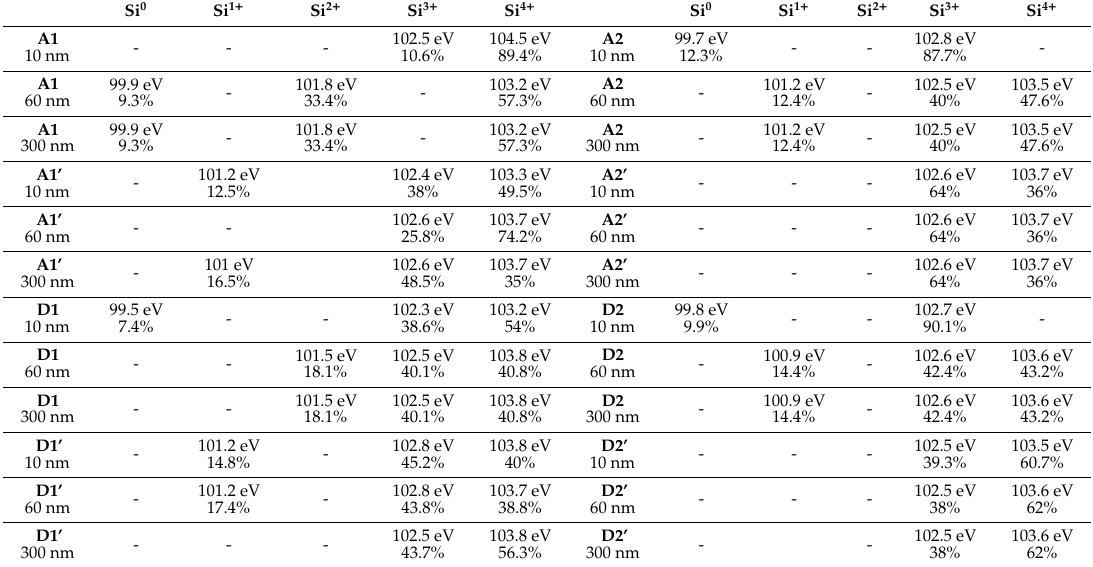
Table 5. Binding energies of the decomposed XPS